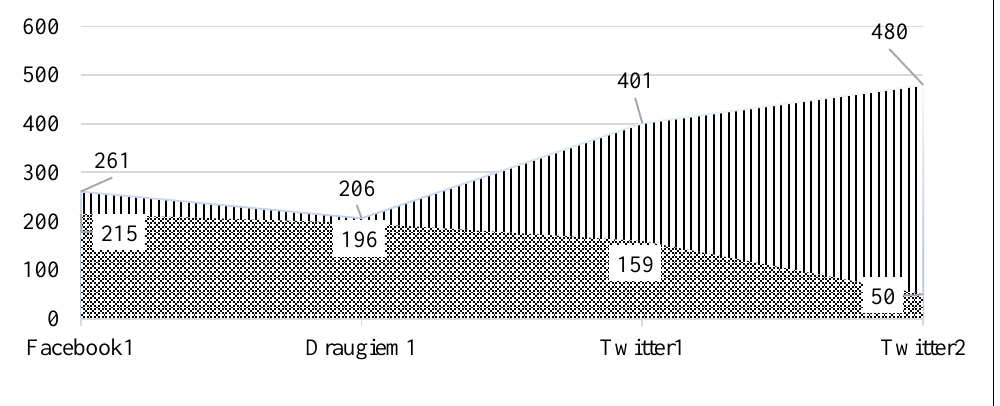
Fig. 1. European Parliament’s social media entries from 1 July to 31 December 2015. Total amount of entries by each social media account and share of entries that are also published on other analysed